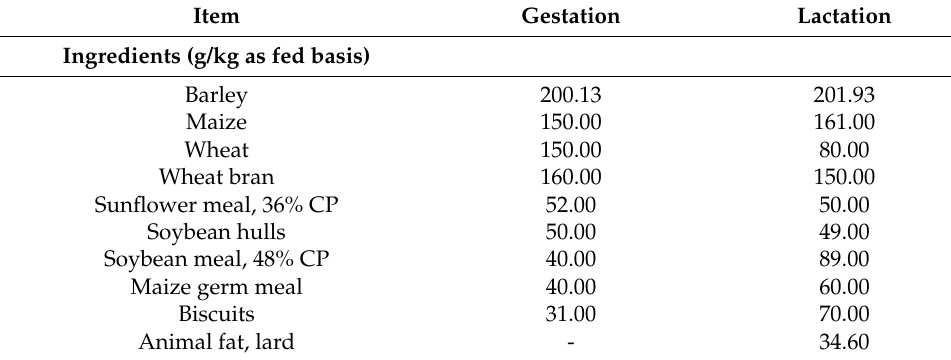
Table 5. Composition of basal sow